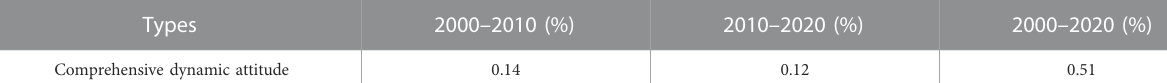
TABLE 4 Comprehensive land use dynamic attitude.